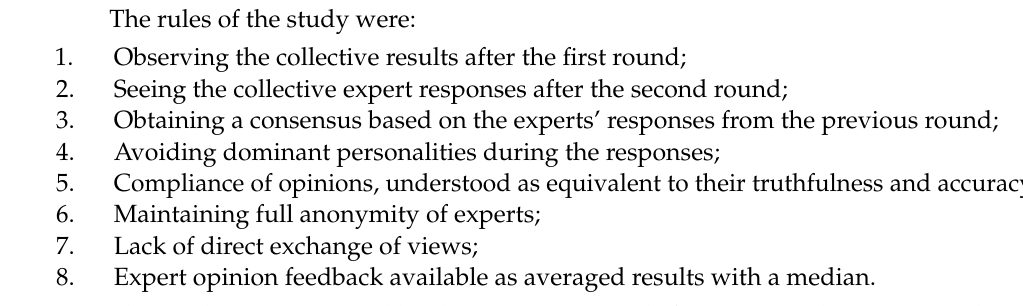
Figure 4. Self-assessment of expert knowledge on a 7-point Likert scale; own elaboration based on the conducted research.